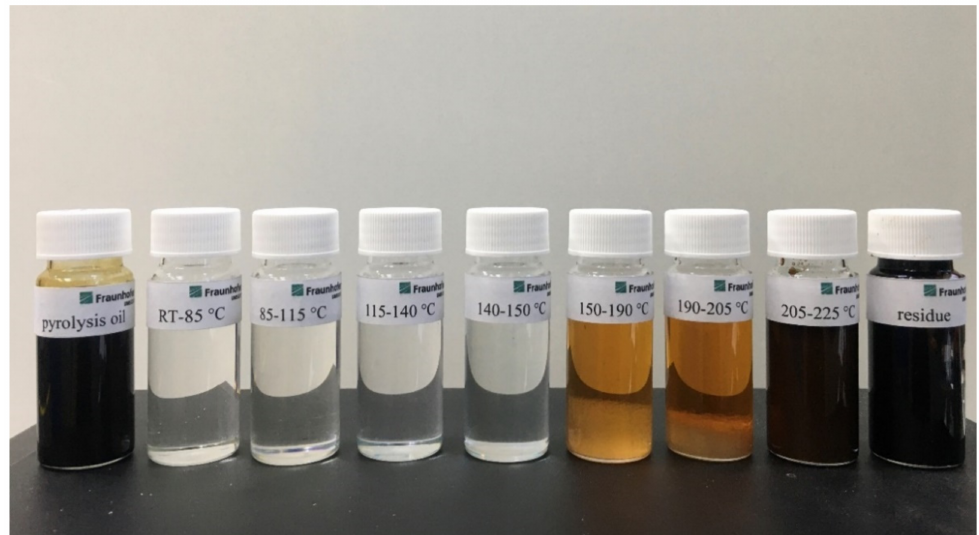
Figure 4. Fractions obtained by fractional